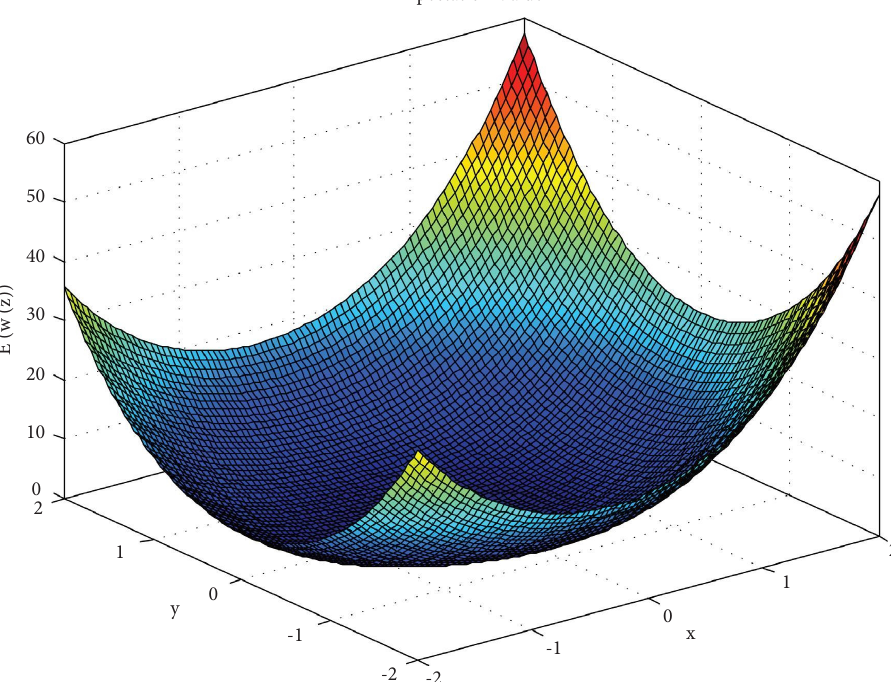
Figure 1: Expected value of equation (17) for α � 1 , β � 2.